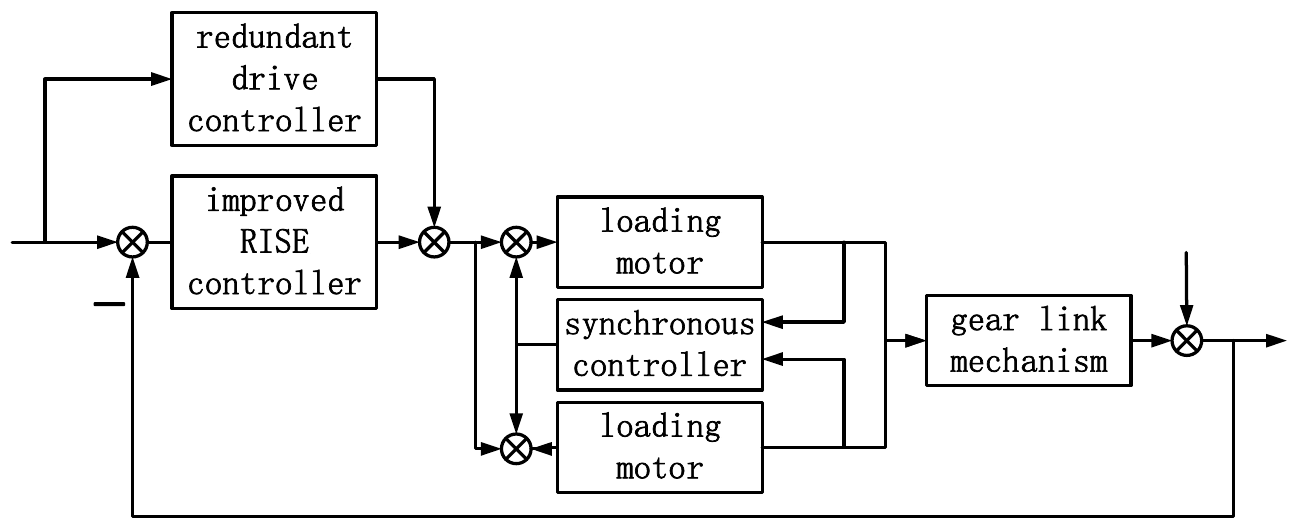
Figure 5. System control structure diagram.